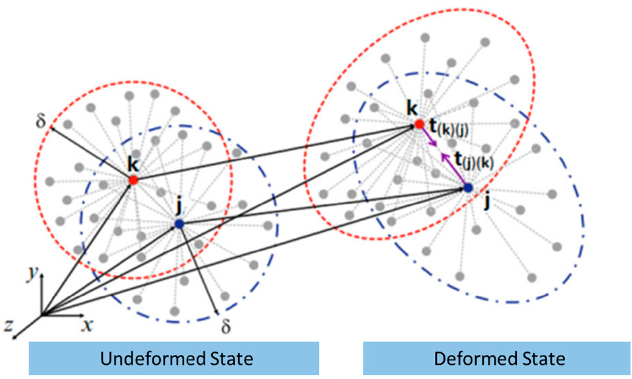
Figure 2. Peridynamics (PD) force density vector and horizon [46].